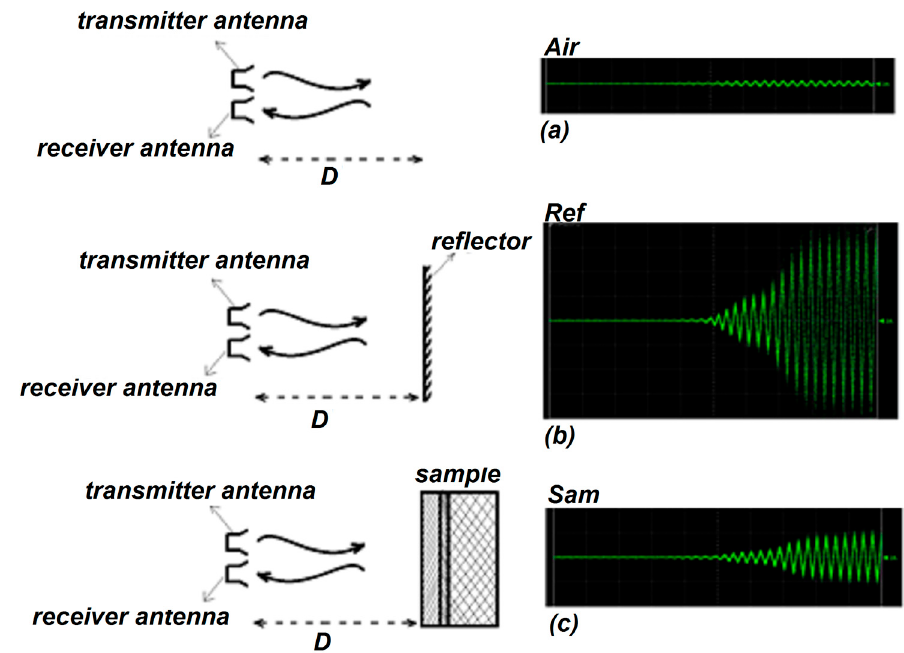
Figure 5. ( a ) Reflection due to crosstalk between transmitter and receiver antennas yields the “Air” signal. ( b ) Reflection from a perfect smooth metallic reflector placed in front of the antennas yields the “Ref” trace. ( c ) Reflection from multi-layered structure placed at the same location that reflector was placed, yields the “Sam” signal.